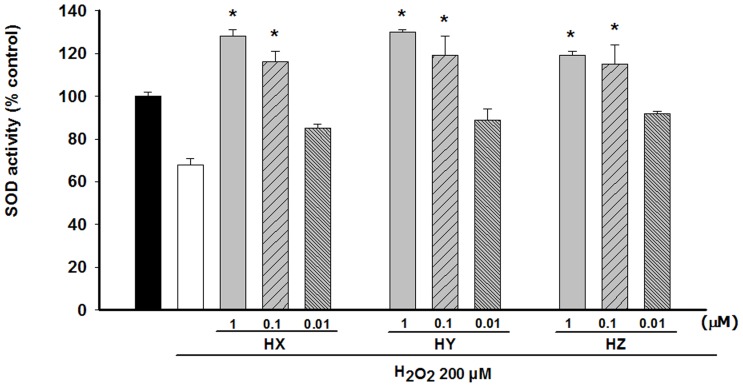
Modulation of the SOD activity in undifferentiated PC12 cells after preincubation with HX, HY and HZ.Cells were incubated with 200 µM H2O2 for 2 h. Huprines were added to the culture 48 h prior to H2O2 addition. SOD activity was measured with a SOD activity assay from Fluka. At least three independent experiments were carried out in triplicate. The data are means ± s.e.m. expressed as percentage of control value. *P<0.05 compared with H2O2 group (Dunnett's test).